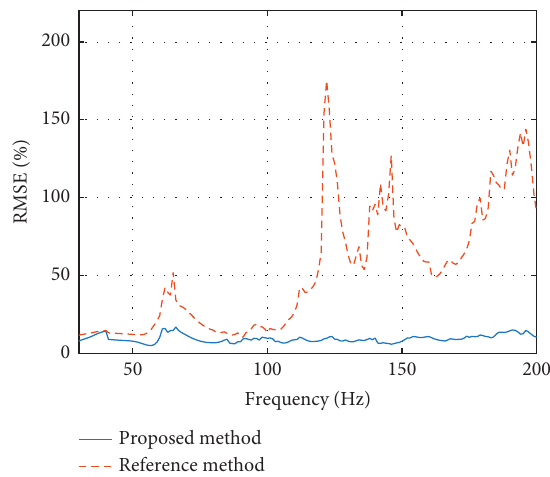
Figure 5: Root Mean Square Errors of the proposed method and the reference method